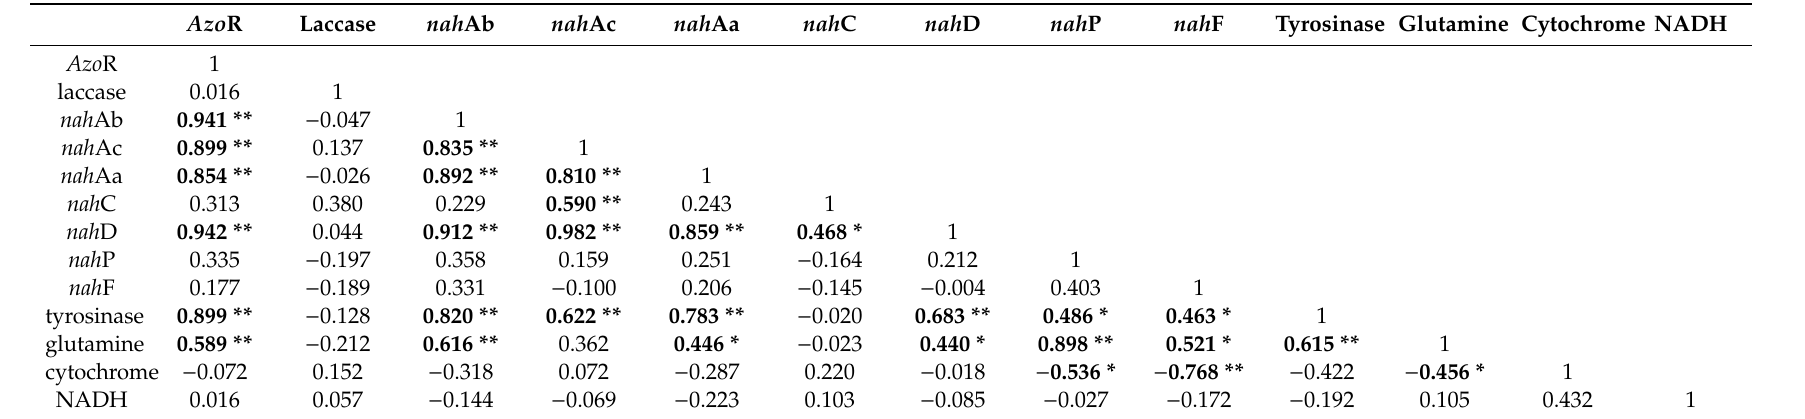
Table 3. Pearson’s correlation coe ffi cient ( r ) between azo dye degrading related genes in sediment samples. (* p < 0.05; ** p <